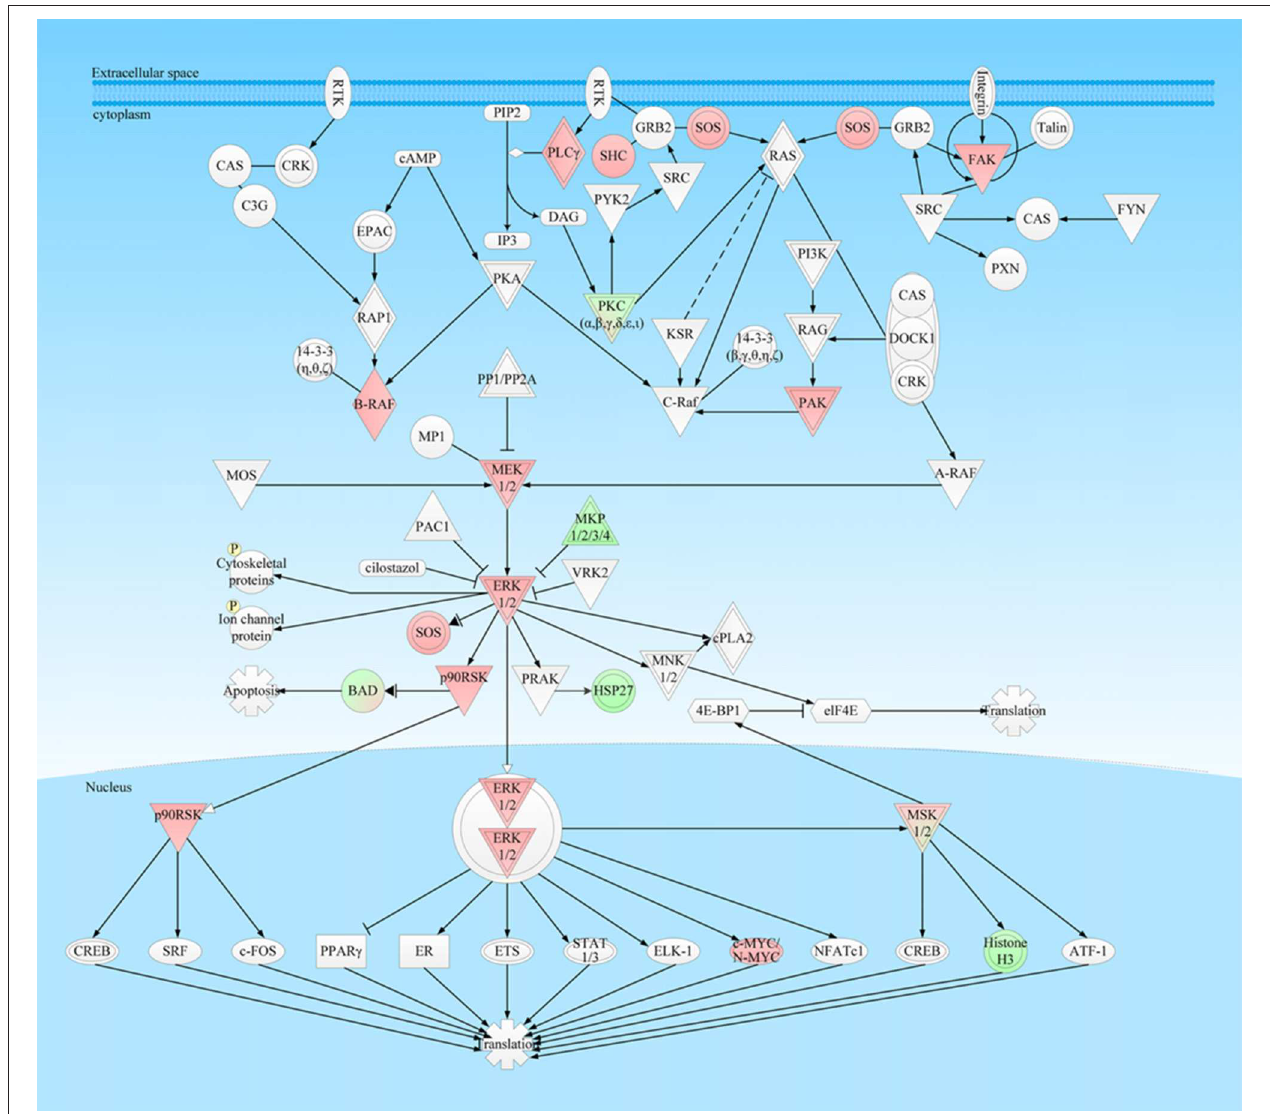
FIGURE 6 | ERK-MAPK signaling pathway was involved in NFPA. This pathway was derived from the IPA analysis results of multi-omics, and then it was modified and verified according to the PTMScan results of NFPAs compared to controls. The red color means upregulation of a molecule in NFPAs, and the green color means downregulation of a molecule in NFPAs. The gradient color degree means slightly different expression tendency of that